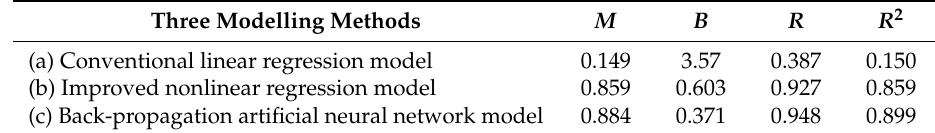
Table 2. Prediction precision indicators of the three modelling methods, where the ideal values are M = 1, B = 0, R = 1 and R 2 =